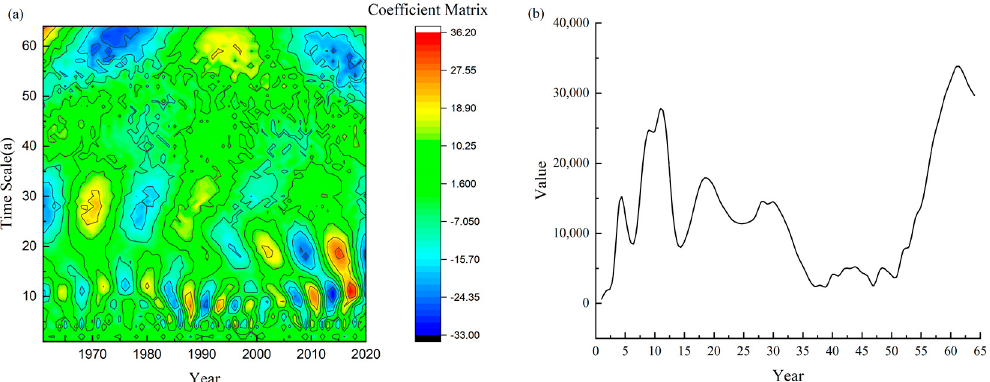
Figure 4. Contour map of the real part of the wavelet coefficients ( a ) and the wavelet variance ( b ) of the precipitation in Xinjiang.